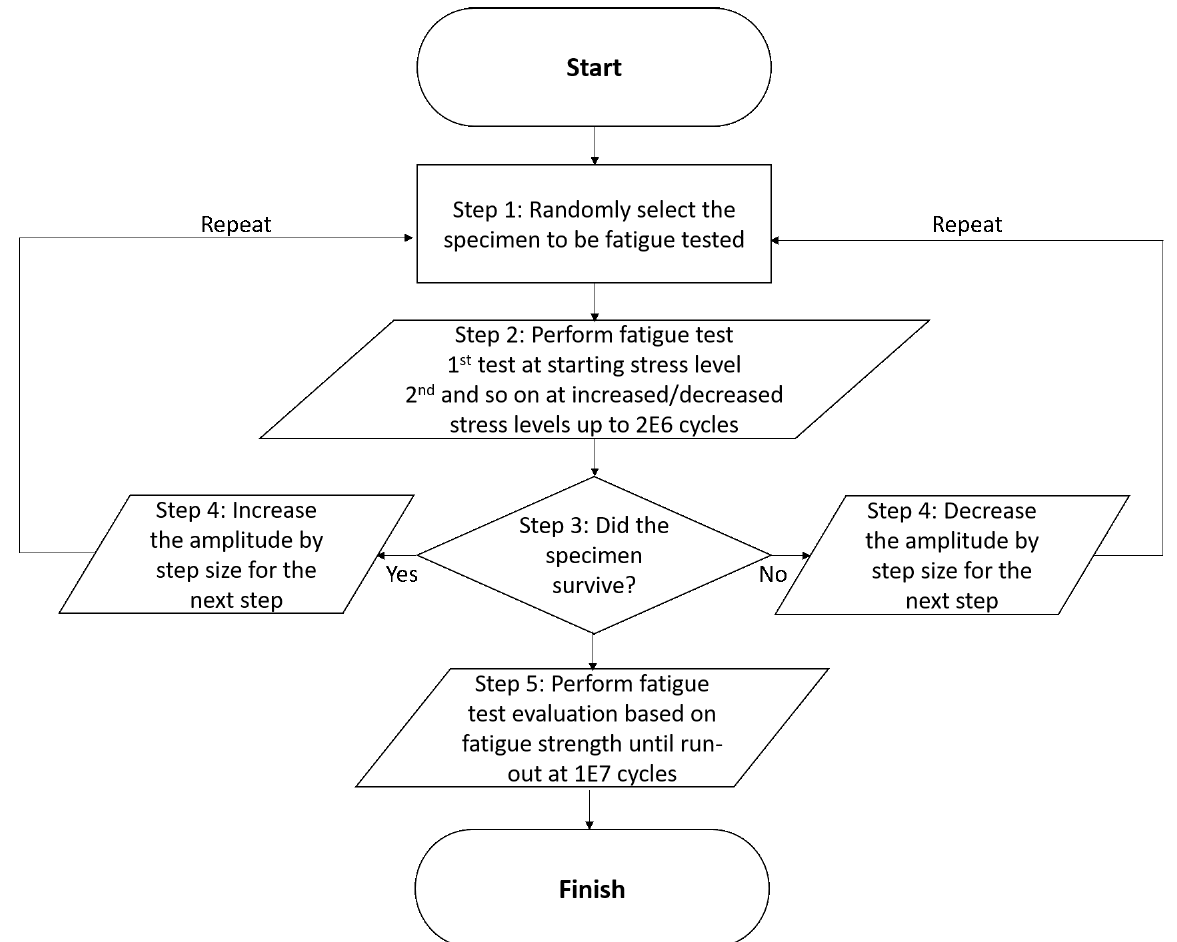
Figure 3: Flow chart of fatigue testing procedures using the staircase